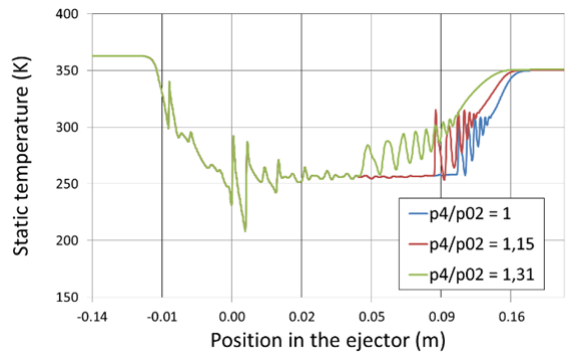
Fig. 7. Static temperature distribution on the ejector axis for the lowest three back-pressures in the on-design regime.